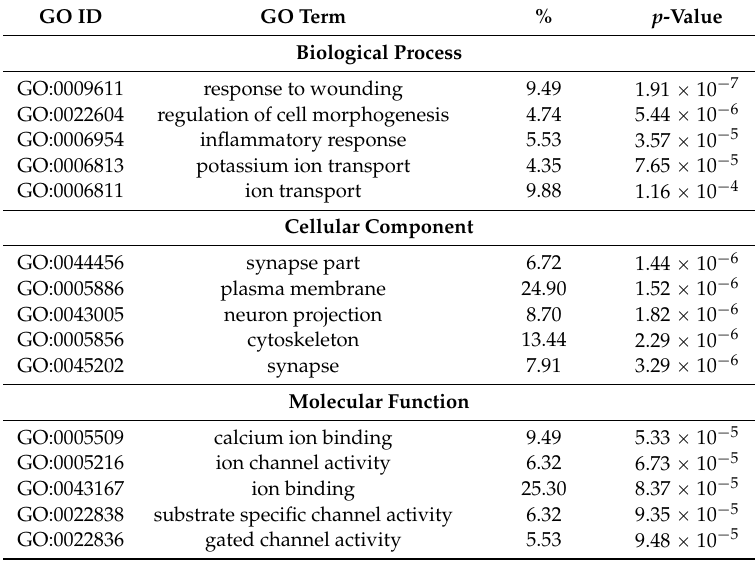
Table 4. GO functional annotation for differentially expressed genes in Rattus norvegicus . (Top